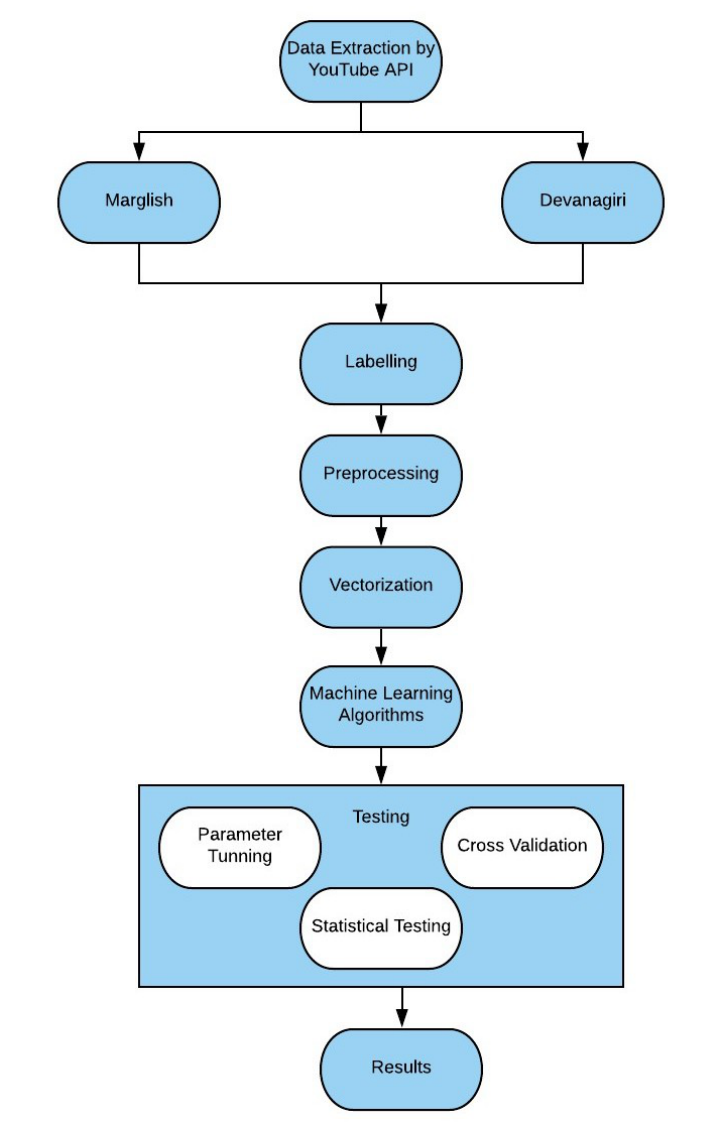
Figure 1. Architecture of Propose